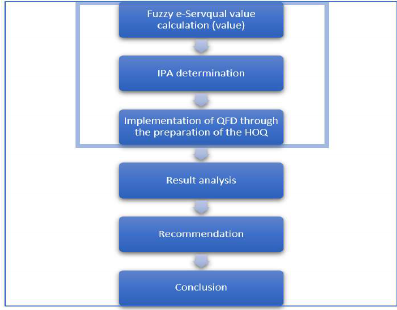
Fig. 1. Structure of Data